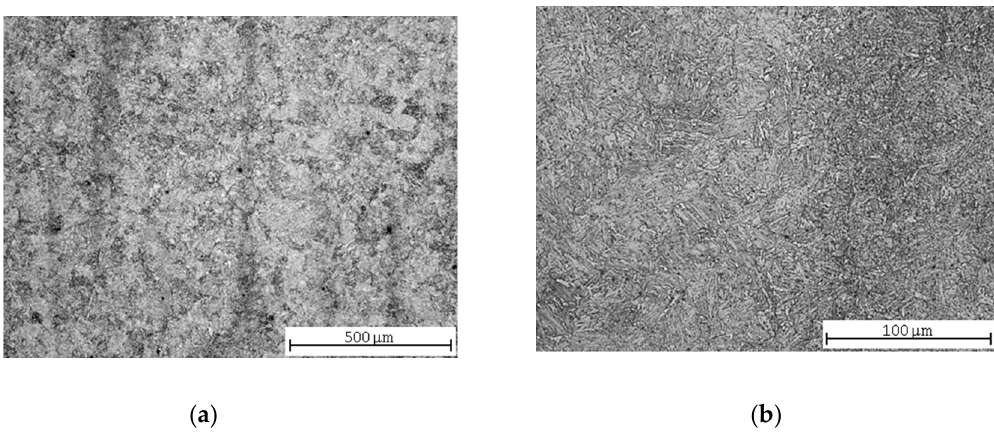
Figure 11. 30CrV9 steel microstructures after quenching: ( a ) central part; ( b ) detail.